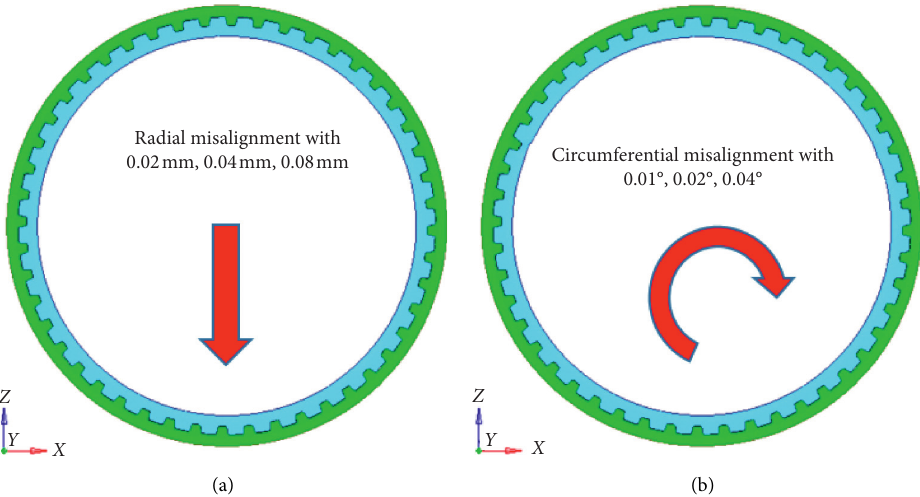
Figure 6: Two spline finite-element model with intentional misalignment: (a) radial misalignment; (b) circumferential